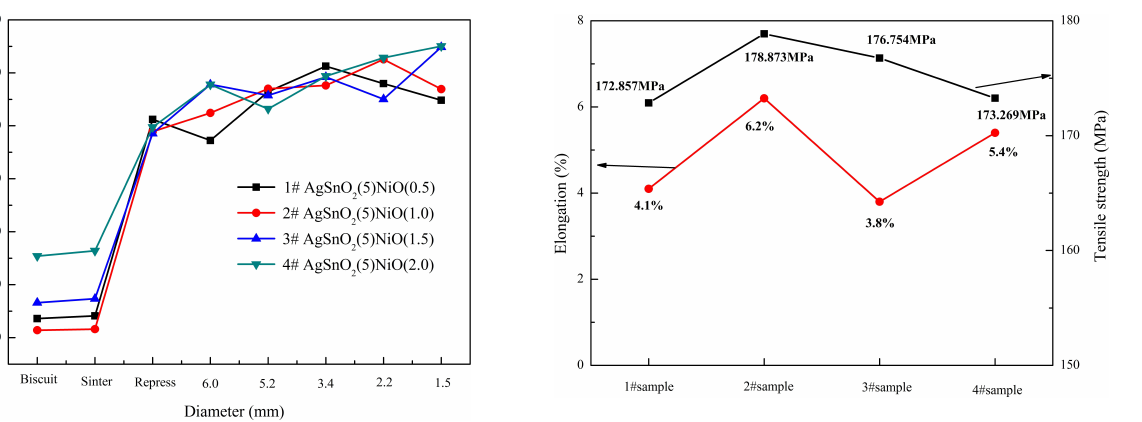
Figure 7: Change trends of microhardness after processing